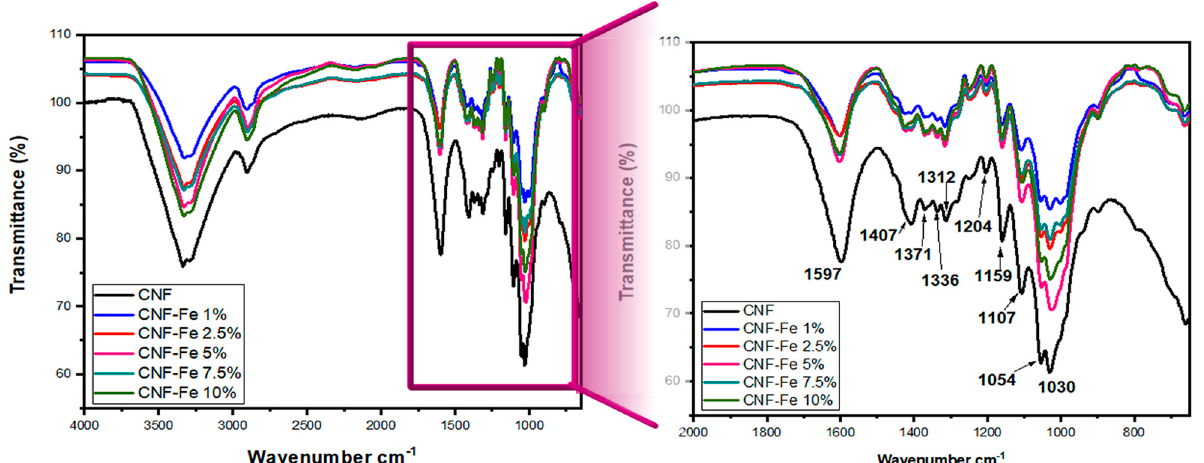
Figure 2. FTIR spectrum of CNF and CNF ‐ iron oxide films.